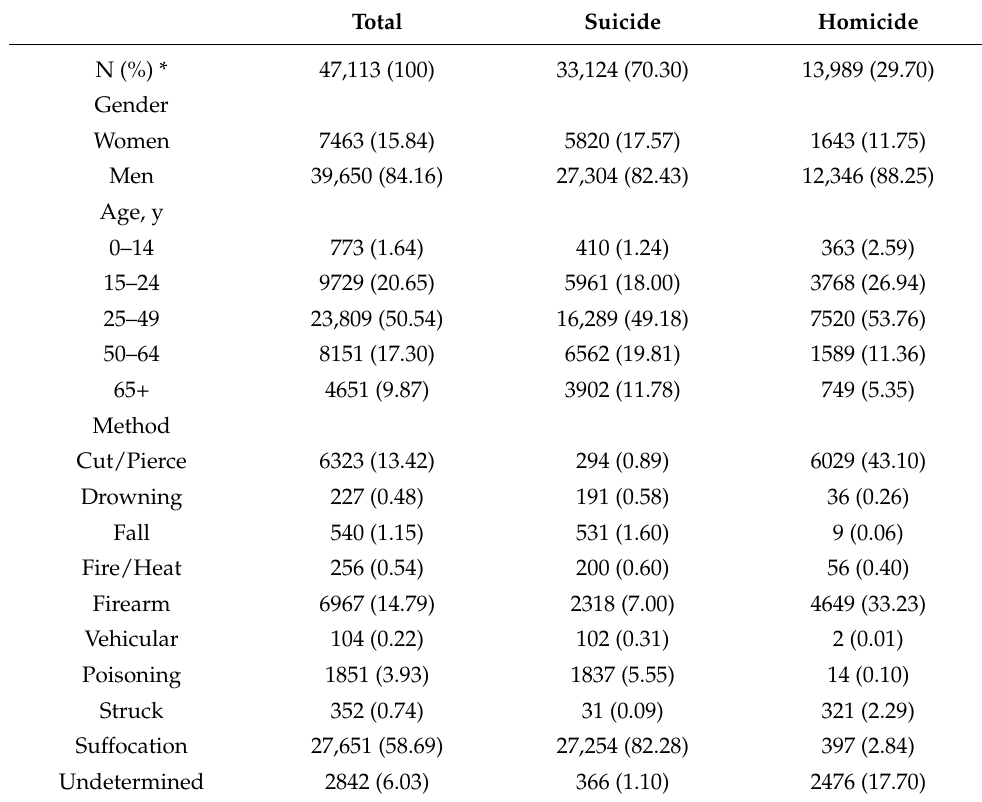
Table 1. Violent death in Chile by intention,